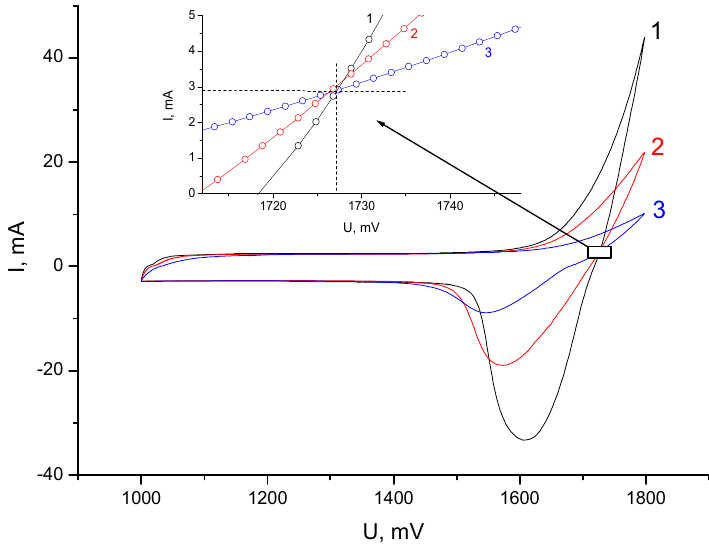
Figure 5. Cyclic voltammograms at a voltage sweep rate of 1 mV/s for: 1—cell 1; 2—cell 2; 3—cell 3. The inset shows an enlarged area of intersection of the curves.